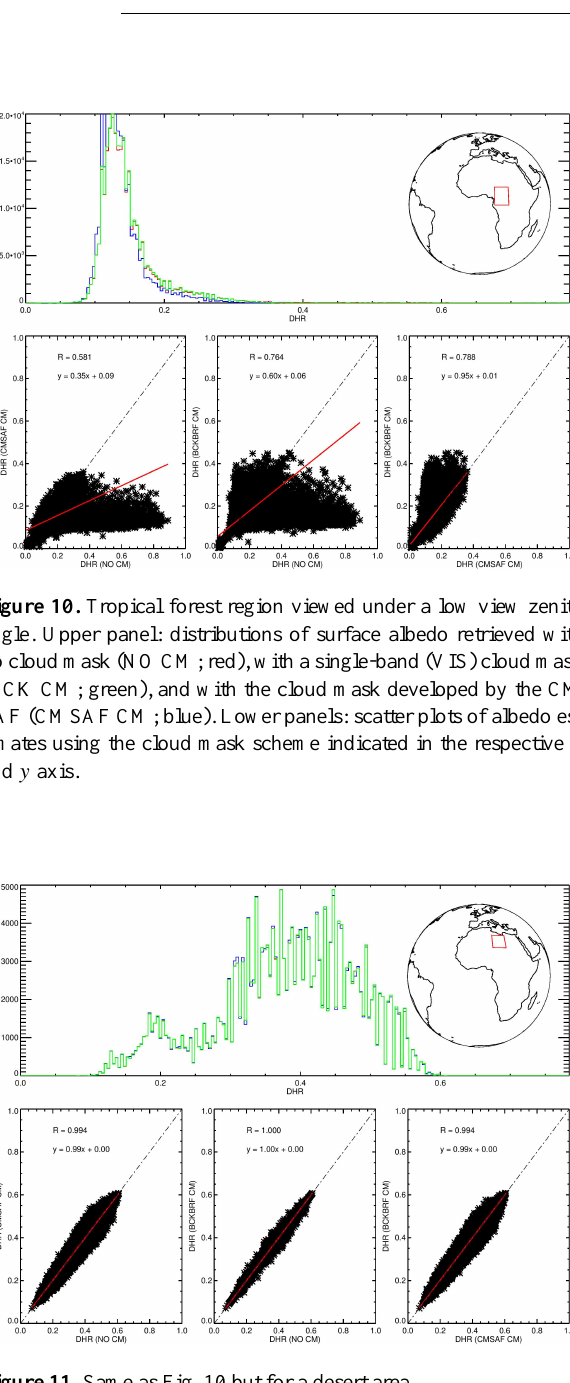
Figure 11. Same as Fig. 10 but for a desert area.